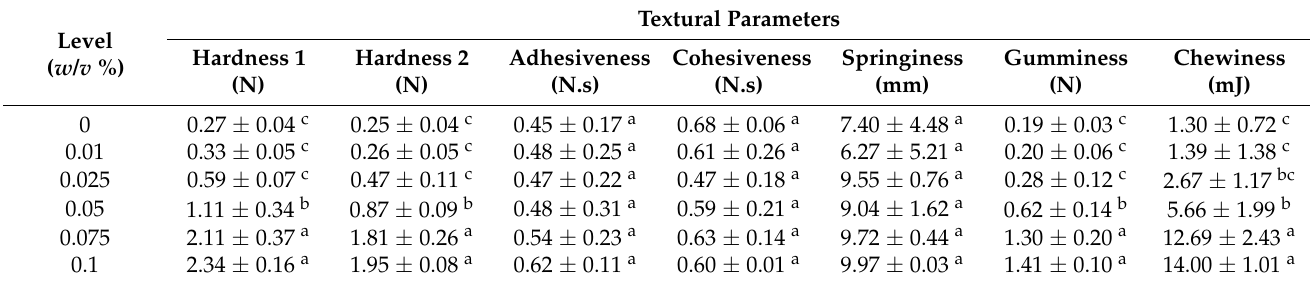
Table 1. Parameters of texture profile analysis (TPA) of soy yogurt with different LAG levels.